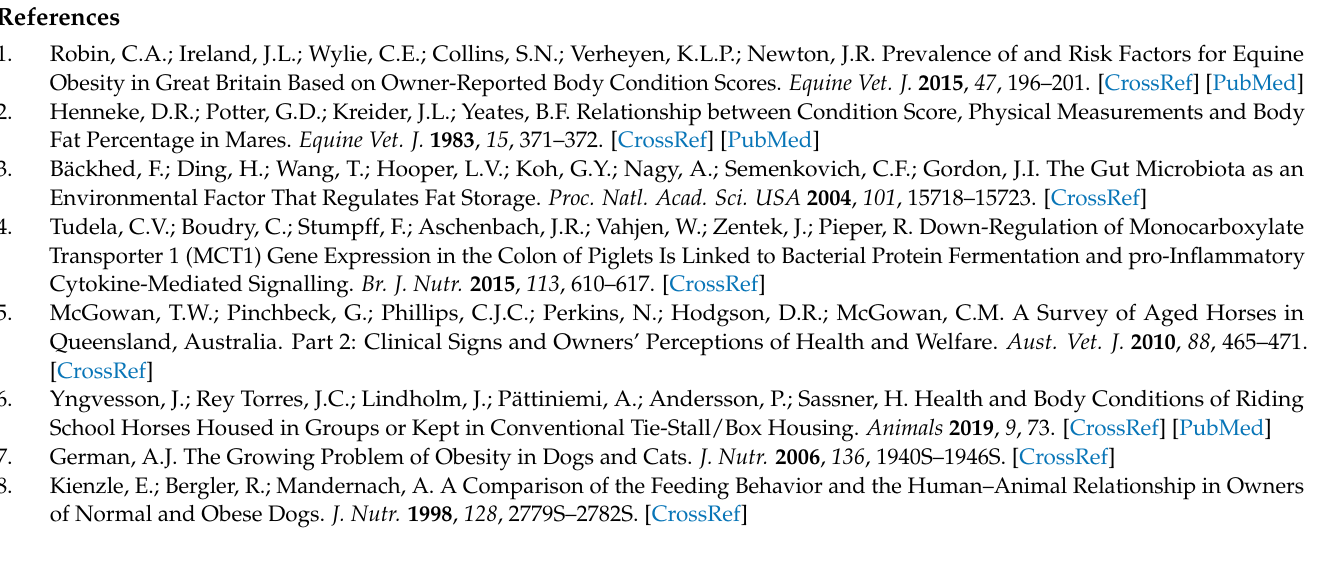
tions, Table S3: ANCOM results of BCS, Farm, Sex, Age category, Breed category and ORKS, Table S4: NCBI accession numbers, Table S5: Sequencing